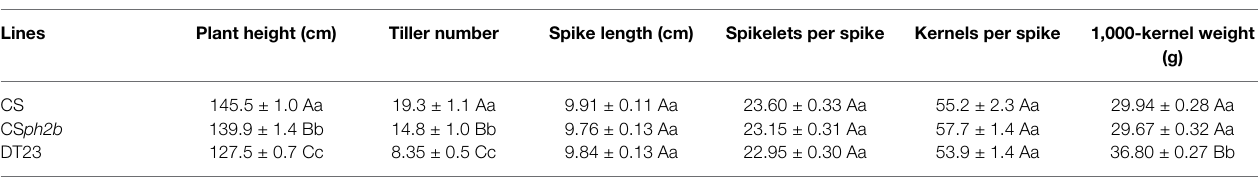
TABLE 4 | Agronomic traits of DT23 and its wheat